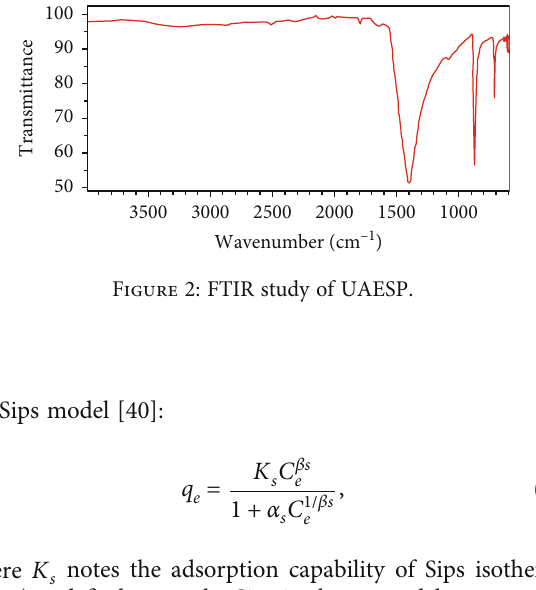
Figure 2: FTIR study of